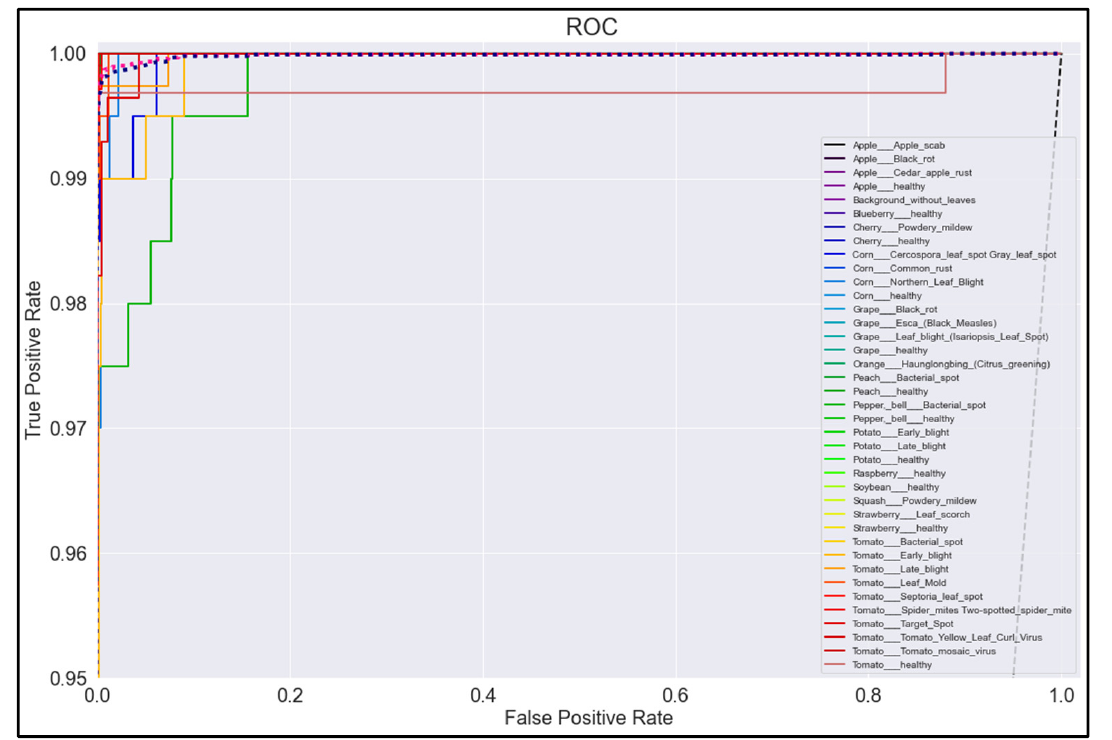
Figure 20. ROC Curve for MobileNetV2 model with transfer learning Scenario 3 and Proposed hyperparameters.